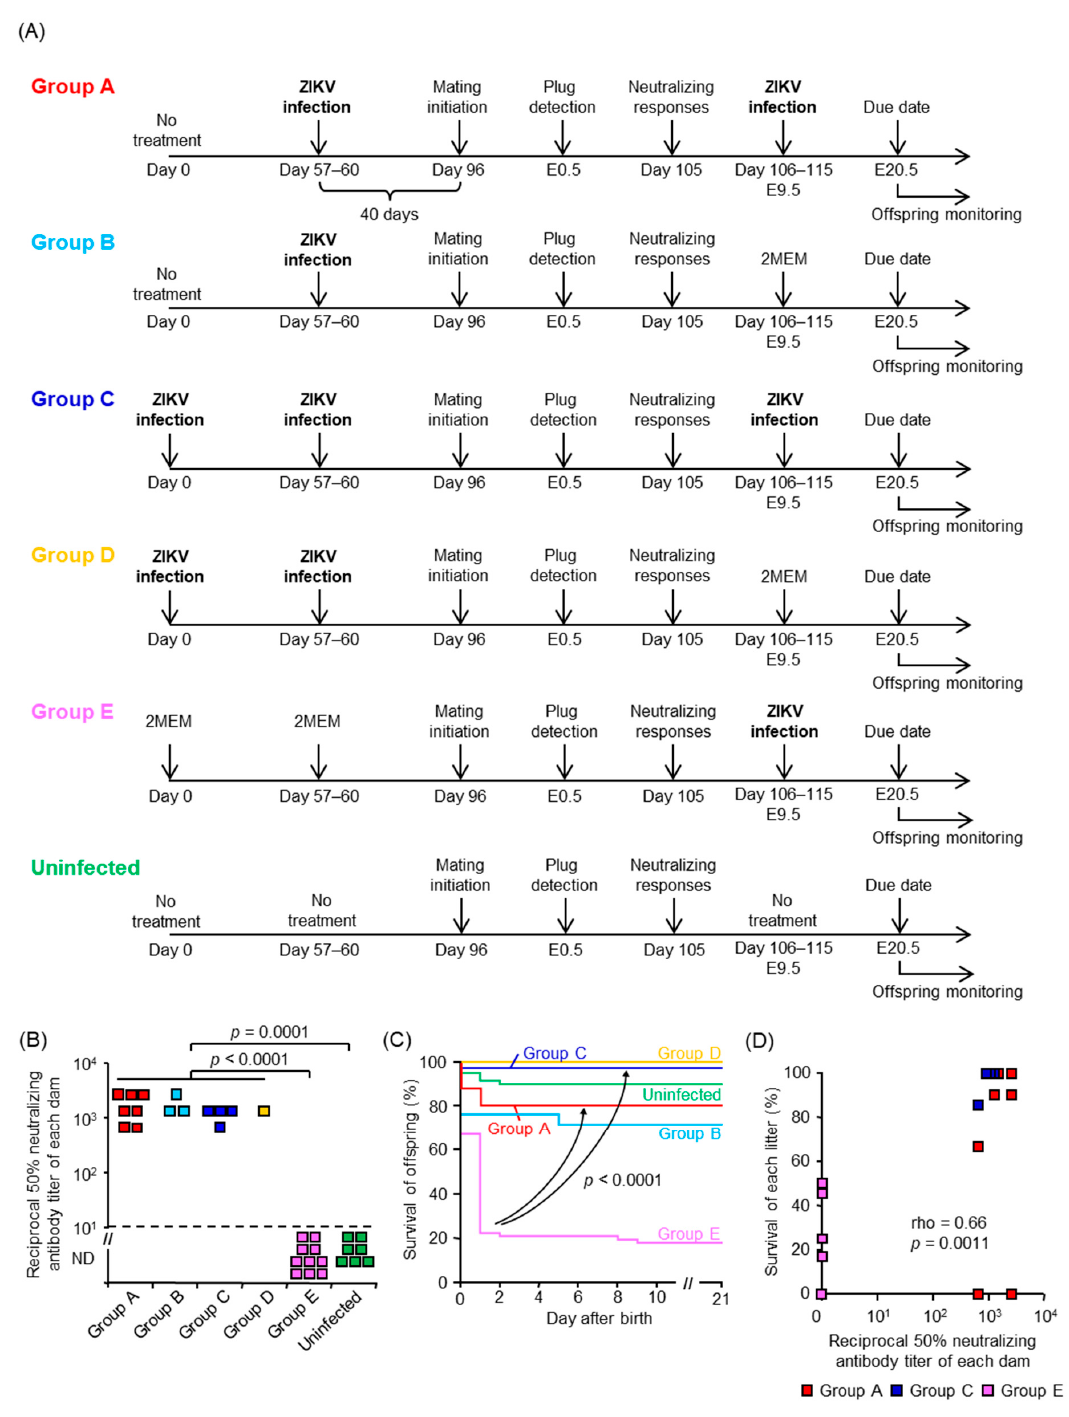
Figure 4. Neutralizing antibodies in dams protect the offspring from vertical ZIKV infection. ( A ) Experimental timeline of each group. ( B ) ZIKV-specific neutralizing antibody titers of each dam. Limit of detection was 1 in 10 dilutions as indicated by the horizontal dashed line. Titer was determined by PRNT 50 assays. Kolmogorov–Smirnov test was used for statistical analysis. ( C ) Survival of offspring. Comparisons for Group E versus either Group A or Group C, p < 0.0001. Comparisons of Kaplan–Meier survival curves between the different groups were performed by log-rank analyses. The data are from 51 offspring from 7 litters for Group A, 21 offspring from 3 litters for Group B, 35 offspring from 4 litters for Group C, 6 offspring from 1 litter for Group D, 67 offspring from 10 litters for Group E, and 60 offspring from 7 litters for the uninfected group. ( D ) Correlation between neutralizing antibody titers of each dam and the percent survival of each litter in Groups A, C, and E. Significance was determined by Spearman’s correlation